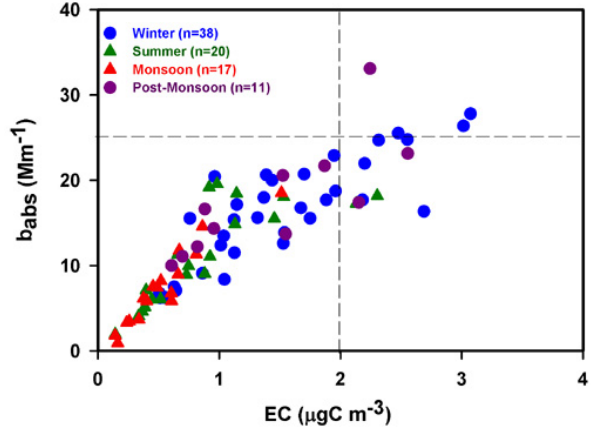
Fig. 7. The scatter plot between b abs and EC concentration exhibit significant correlation up to 25Mm − 1 (shown by horizontal dashed line) and 2.0µgCm − 3 (shown by vertical dashed line). The linear- ity ceases at higher EC concentrations and high b abs values.